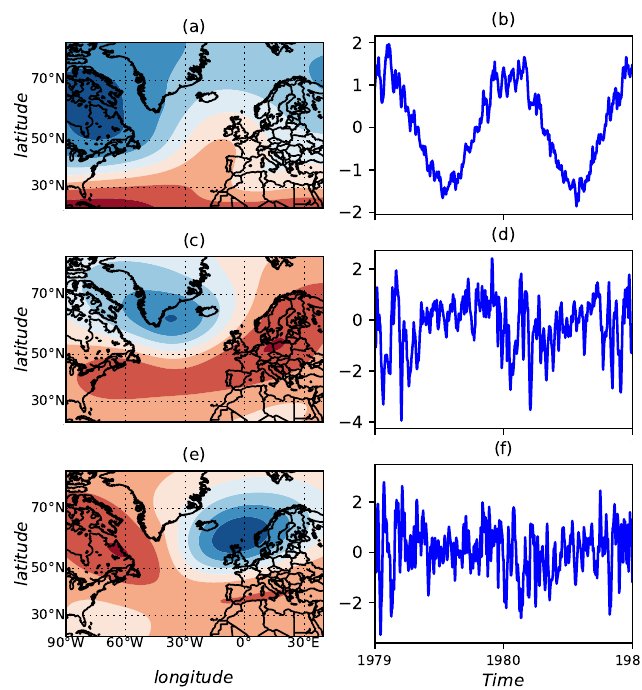
Figure 3. First EOFs (left) and first five PCs (right) of the PCA performed on the fitting and validation period on the North Atlantic/Europe domain of ERA-Interim Z500 dataset. ( a ) EOF and ( b ) PC corresponding to the seasonal pattern. ( c ) EOF and ( d ) PC corresponding to North Atlantic Oscillation pattern. ( e ) EOF and ( f ) PC corresponding to Scandinavian